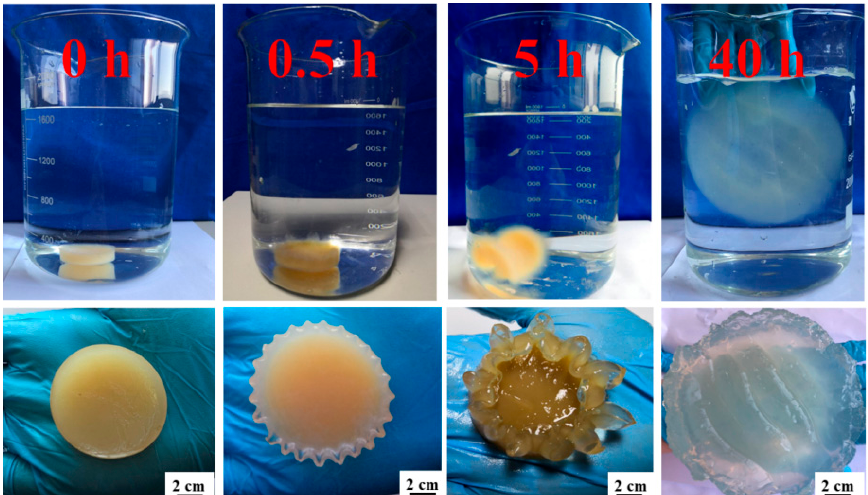
Figure 1. Photographs showing swelling and size-change of CNC-g-AA-2-120-8 gel in distilled water over time.